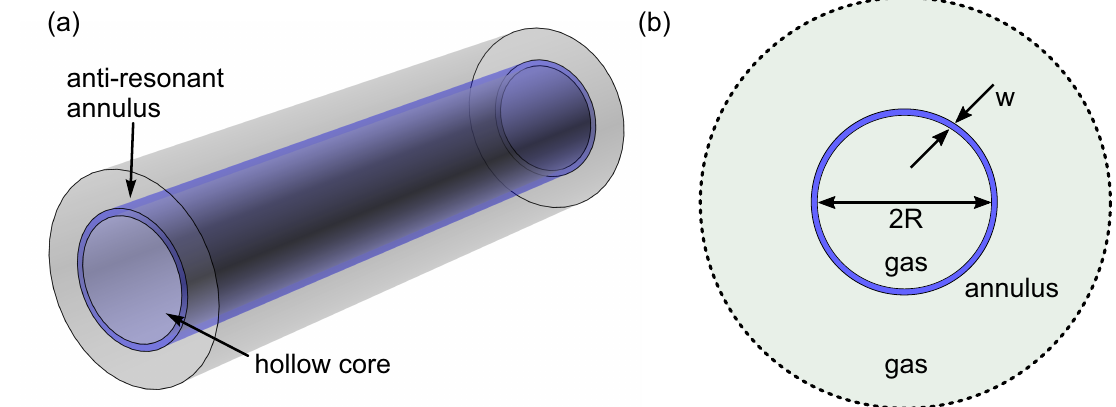
Figure 2. ( a ) sketch of the tube-type anti-resonant hollow core fiber (TTF) geometry that is used to approximate the dispersion properties of RTFs (a cross section of this geometry including the relevant parameters in shown in ( b )). This structure is composed of a thin annulus of dielectric material containing a low index medium in the core and the most outer